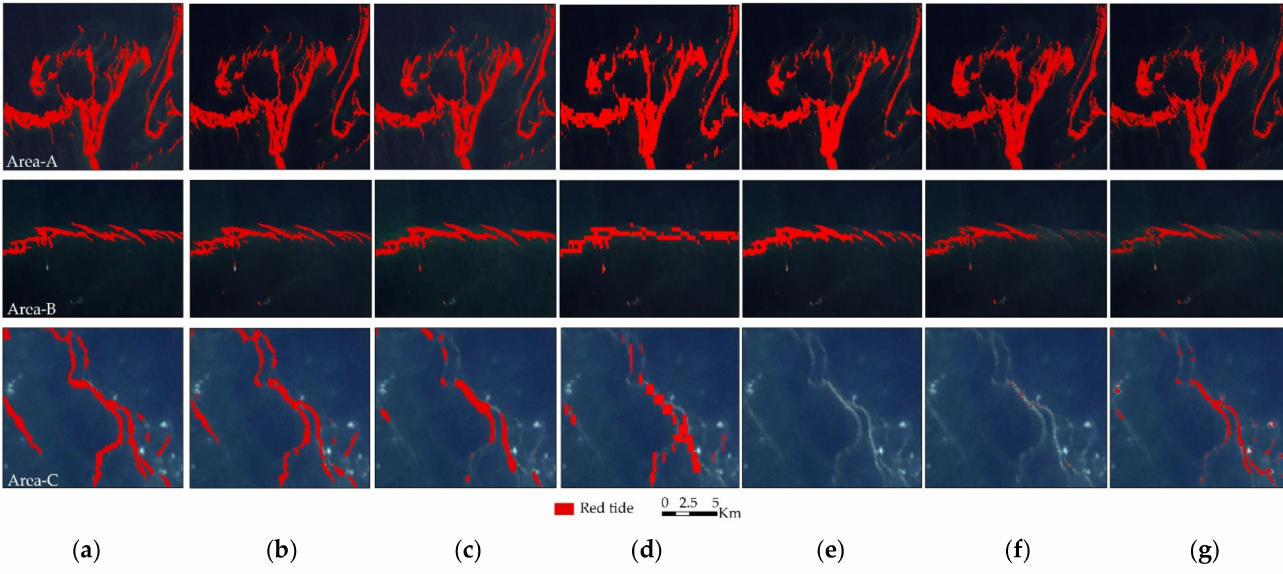
Figure 8. Local view of red tide detection results based on different methods. ( a ) Validation map; ( b ) RDU − Net; ( c ) U − Net; ( d ) FCN − 8s; ( e ) SegNet; ( f ) SVM; ( g ) GF1_RI. The red regions represent red